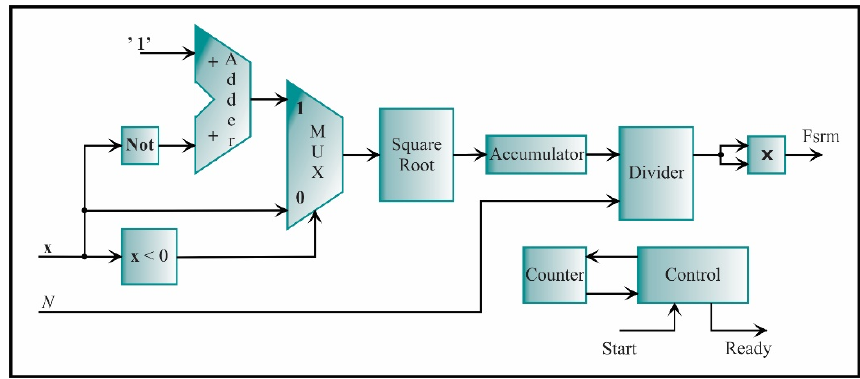
Figure 16. The architecture of the processing core for computing the SRM.